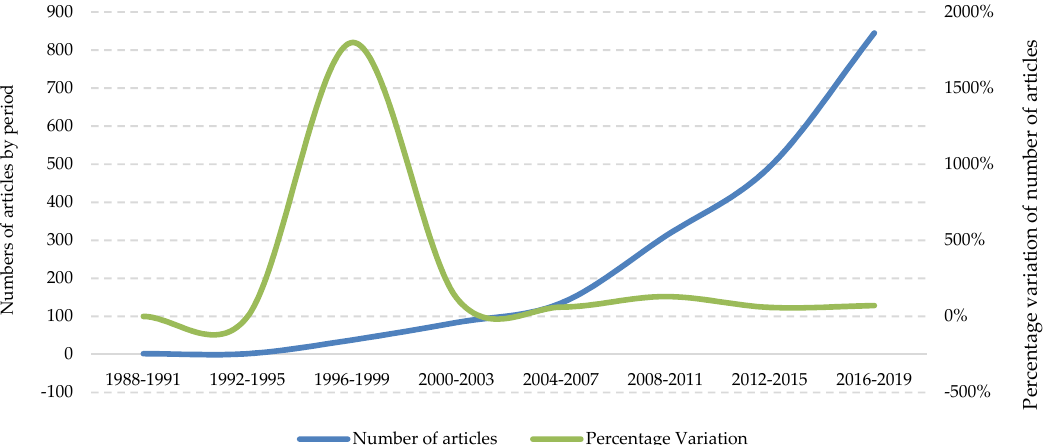
Figure 2. Evolution of the number of articles and percentage of variation between four-year periods.